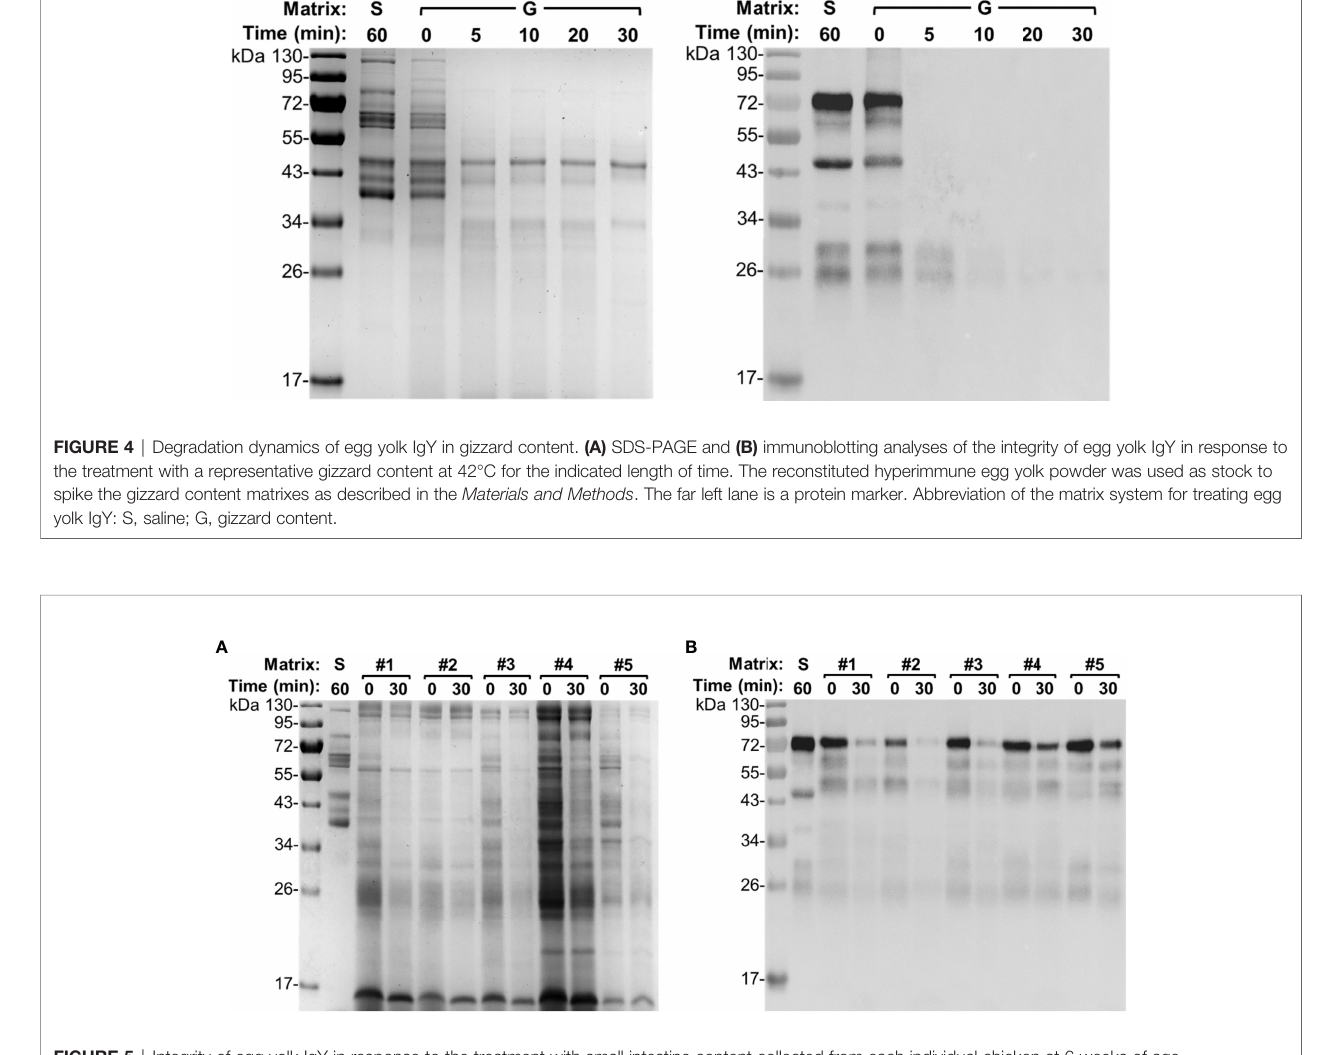
FIGURE 5 | Integrity of egg yolk IgY in response to the treatment with small intestine content collected from each individual chicken at 6 weeks of age. (A) SDS-PAGE and (B) immunoblotting analyses of the integrity of egg yolk IgY in response to the treatment with each individual small intestine content collected at 6 weeks of age at 42°C for 0 or 30 min. The reconstituted hyperimmune egg yolk powder was used as stock to spike the small intestine content matrixes as described in the Materials and Methods . The far left lane is a protein marker. Abbreviation of the matrix system for treating egg yolk IgY: S, saline; #1 – #5, small intestine contents of fi ve individual chickens at 6 weeks of